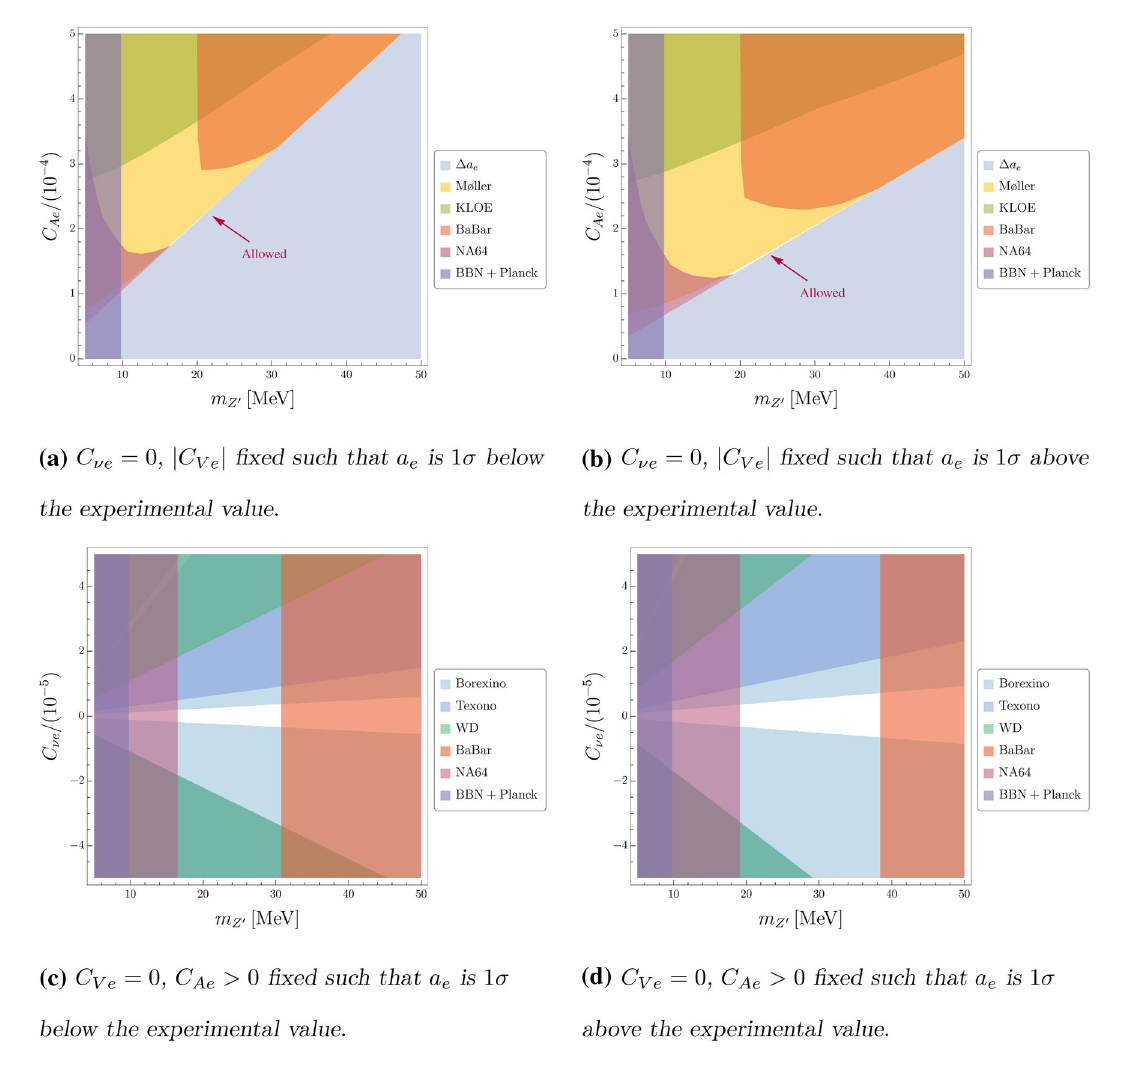
Fig. 2 Constraints on the mass and effective couplings of the Z (cid:2) to the electron sector. In the upper plots, we have set C ν e = 0 and taken | C Ve | so that the contribution of the Z (cid:2) loop induces a value of a e which is a 1 σ below, and b 1 σ above the experimental value. The shaded regions are excluded and in each plot a thin white strip of allowed parameter